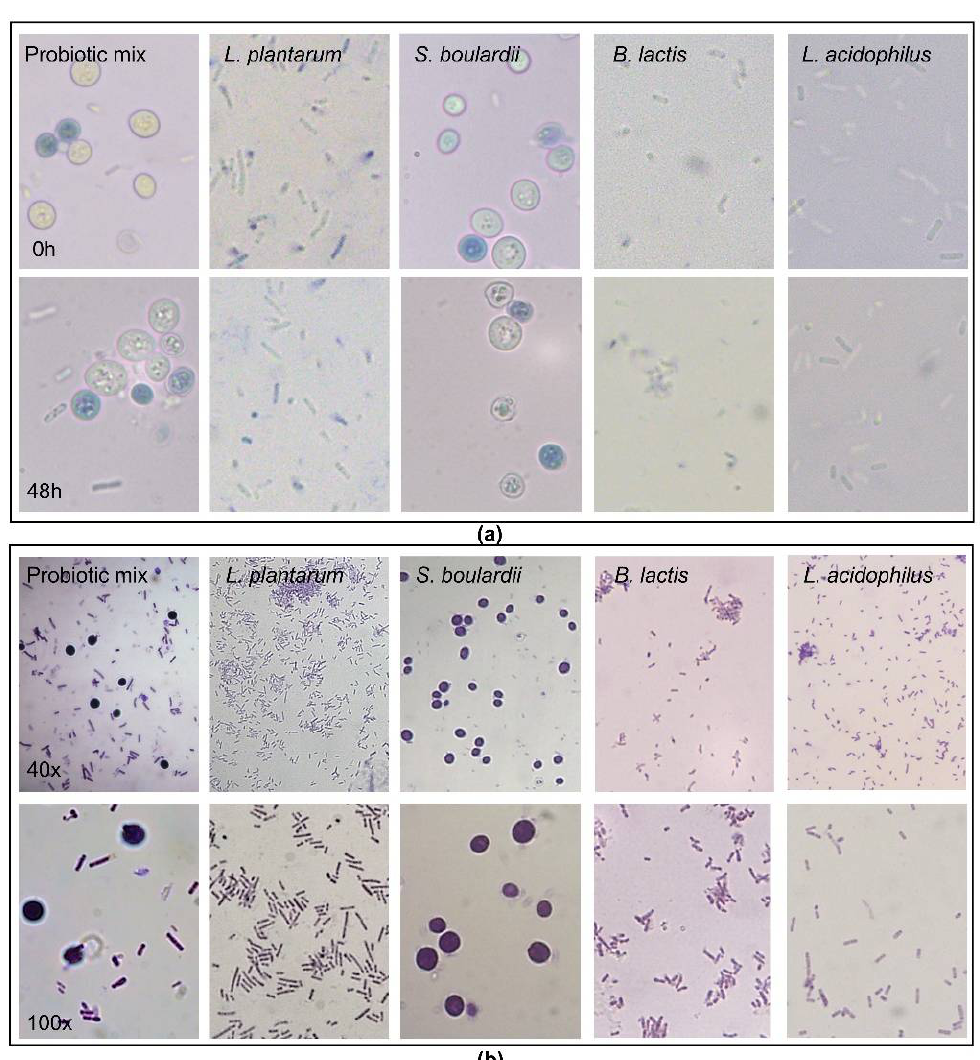
Figure 1. ( a ) Optical representation of Trypan Blue staining of the Probiotic mix, Lactiplantibacillus plantarum , Saccharomyces boulardii , Bifidobacterium lactis and Lactobacillus acidophilus at the time of dilution (0 h) and after 48 h incubation. ( b ) Gram staining of the Probiotic mix, Lactiplantibacillus plantarum , Saccharomyces boulardii , Bifidobacterium lactis and Lactobacillus acidophilus using 40× and 100× magnification.